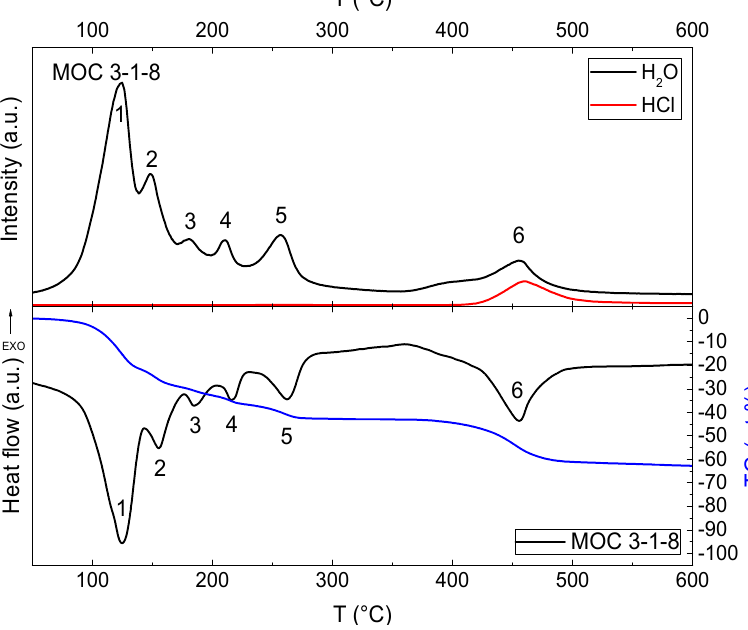
Figure 7. Simultaneous thermal analysis–mass spectroscopy (STA-MS) of MOC 3-1-8 measured in an inner atmosphere: MS signals for water and hydrochloric acid ( up ) and DTA plus TG signals ( down ).